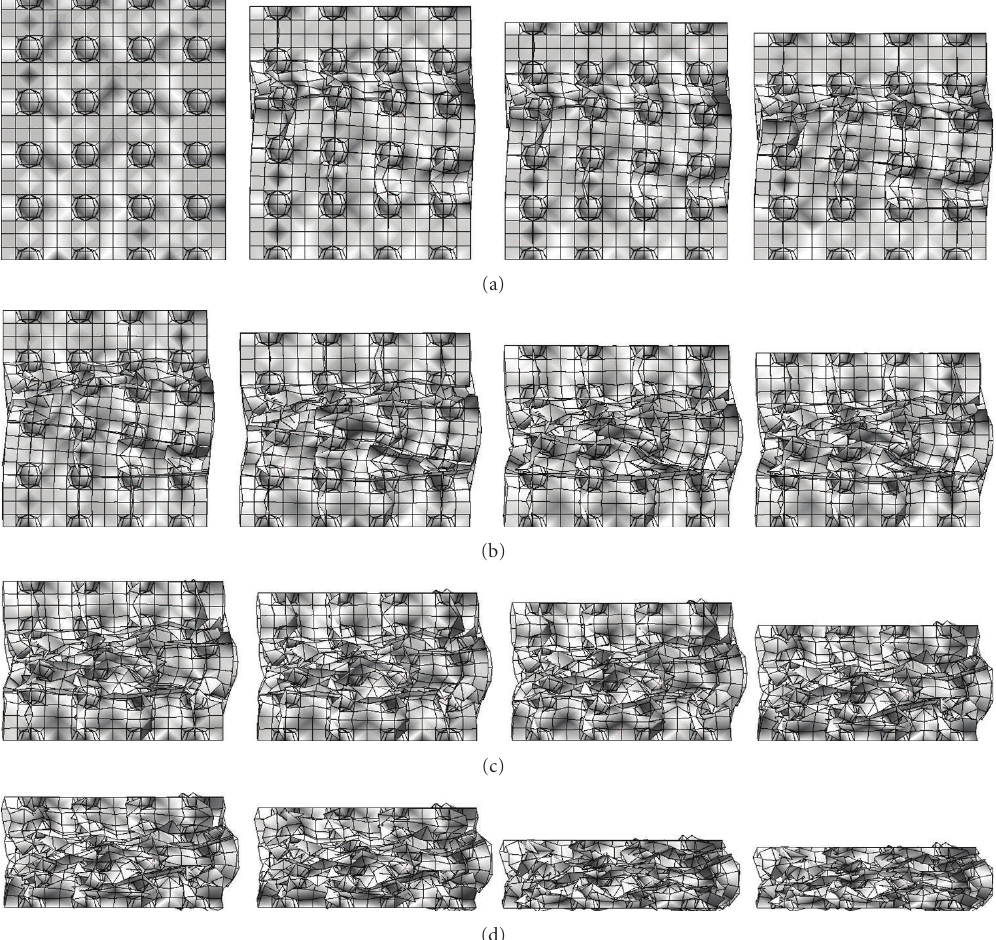
Figure 12: Two-dimensional views of the model in case of deformation pattern-III: (Irregular deformation ) obtained from simulation when both the in-plane and through thickness density variations were